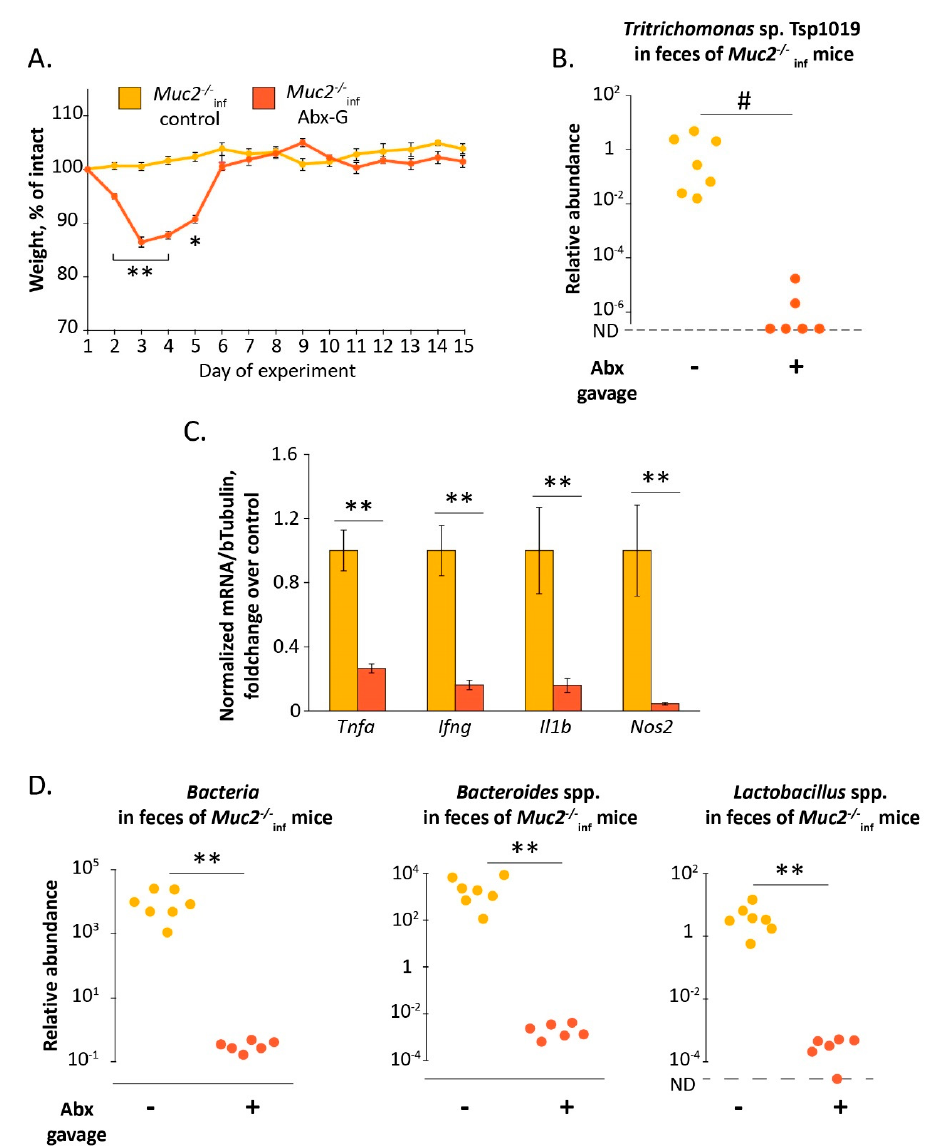
Figure 4. Suppression of Tritrichomonas sp. by antibiotic treatment by gavage results in the recovery of the infected Muc2 − / − mice. ( A ) Body weight dynamics upon antibiotic treatment. *, **—“ Muc2 − / − inf control” vs. “ Muc2 − / − inf Abx-G”, p < 0.05, p < 0.01, Mann–Whitney u-test. ( B ) Relative abundance of Tritrichomonas sp. T.sp1019 in feces on the day 15, normalized on Mus musculus 28S rRNA gene. #—differences between groups p < 0.05, Fisher Exact test. ND—not detected. ( C ) Gene expression in colon tissue normalized on beta Tubulin (Tubb5) gene. **—differences between groups p < 0.01, Mann– Whitney u-test. ( D ) Relative abundance of the gut bacteria in feces on the day 15, normalized on Mus musculus 28S rRNA gene. **—differences between groups p < 0.01, Mann–Whitney u-test. ND—not detected. Experimental groups: “con- trol”—gavage with drinking water; “Abx-G”—gavage with the antibiotics.